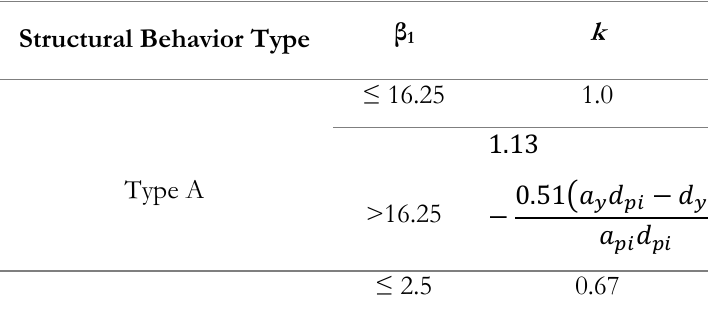
Table 1. Modification factor